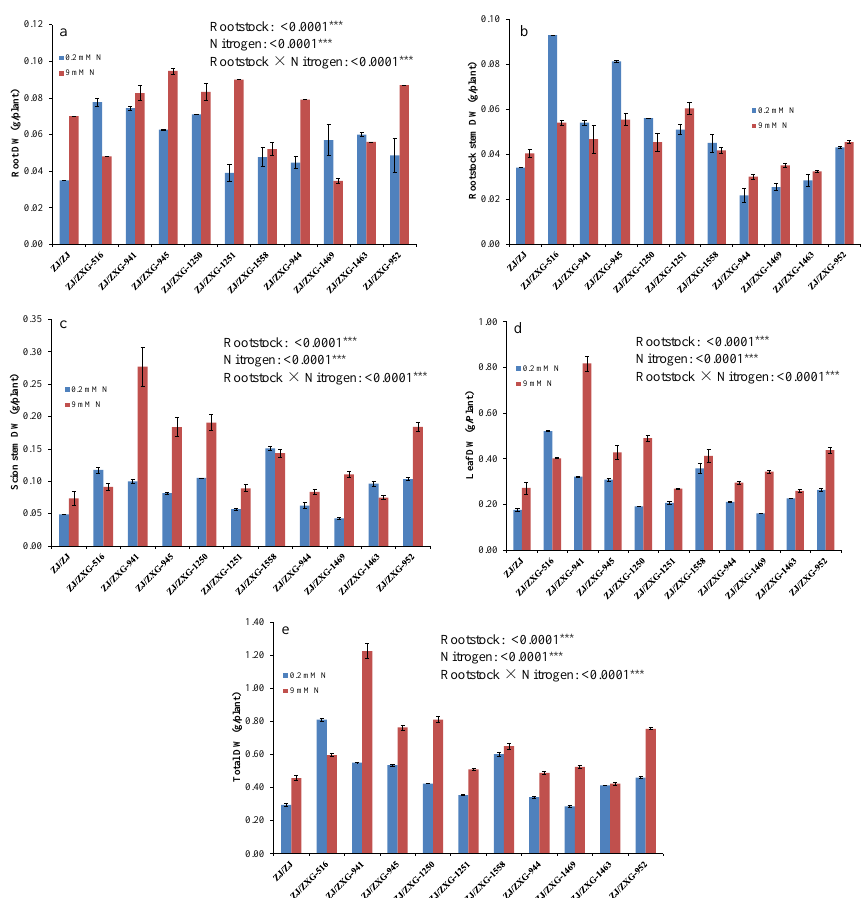
Figure 1. Root dry weight ( a ), rootstock stem dry weight ( b ), scion stem dry weight ( c ), leaf dry weight ( d ), and total dry weight ( e ) of watermelon cultivar Zaojia 8424 (ZJ), self-grafted (ZJ/ZJ) and grafted onto 10 different wild watermelon rootstocks, under normal (9 mM) and low (0.2 mM) nitrogen (N) conditions. Values are means ± standard error (SE) of three replicates. *** represent P ≤ 0.05 .